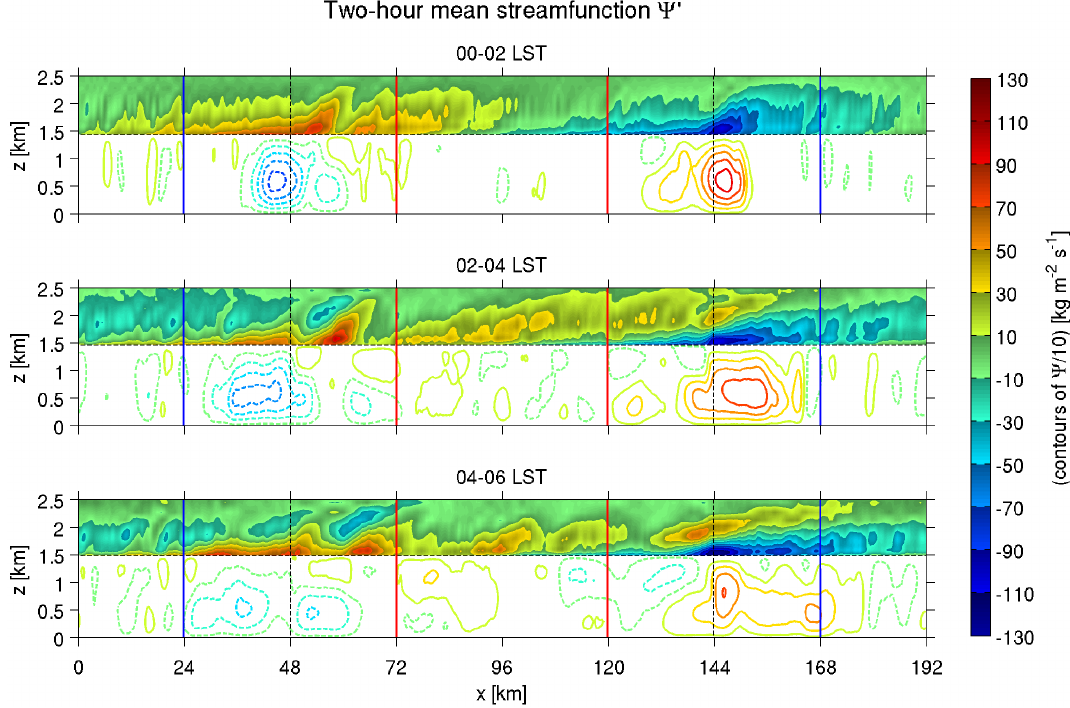
Fig. 12. y and two-hour time-averaged x - z cross-sections of the perturbation streamfunction Ψ 0 . The filled circulations are above the domain mean inversion. Contours are on the same color scale as the filled region, but are an order of magnitude larger in value. boundary associated with convergence at the leading edge of the mesoscale cold pool spreading outwards from the